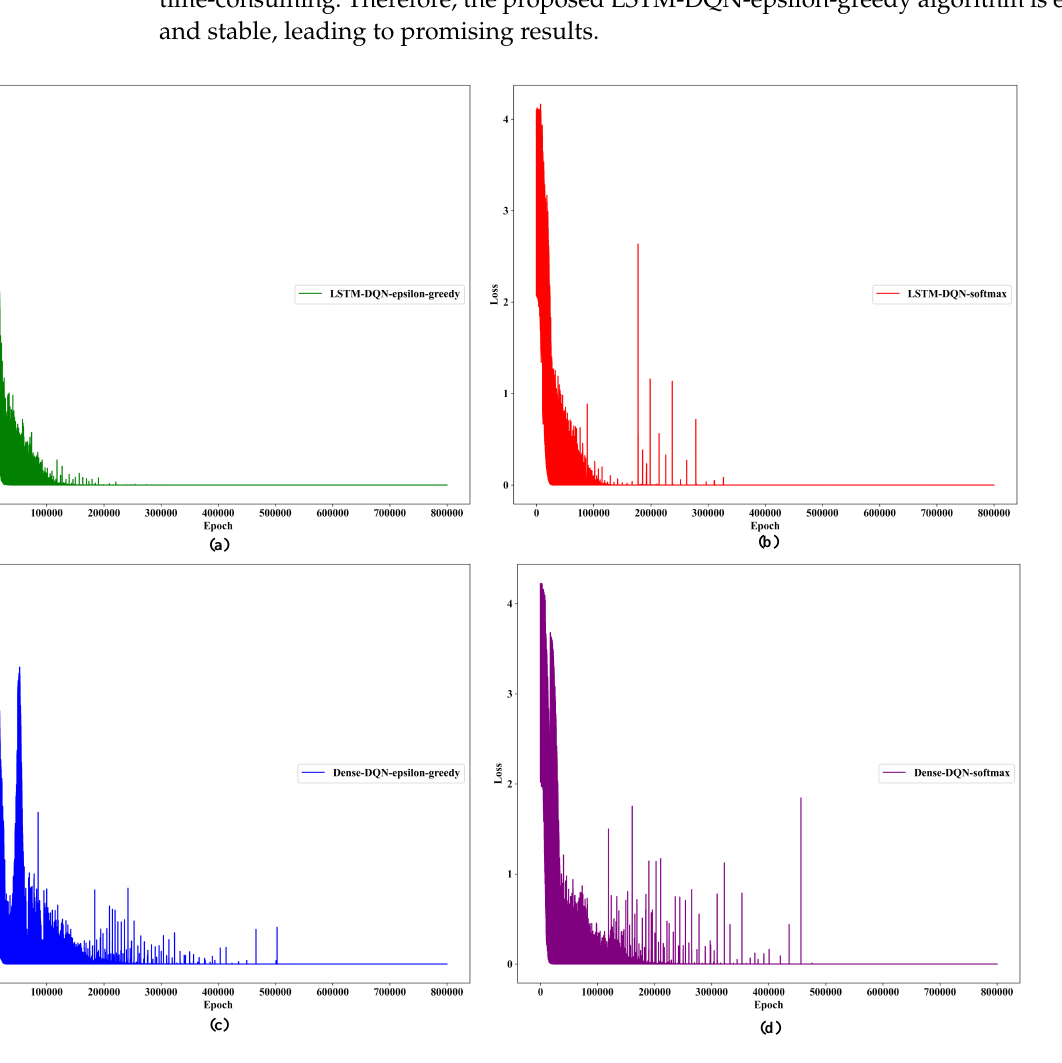
Figure 11. Loss convergence per epoch during training: ( a ) loss convergence for proposed epsilon-greedy-LSTM-DQN; ( b ) loss convergence for softmax-LSTM-DQN; ( c ) loss convergence for epsilon-greedy-Dense-DQN; ( d ) loss convergence for